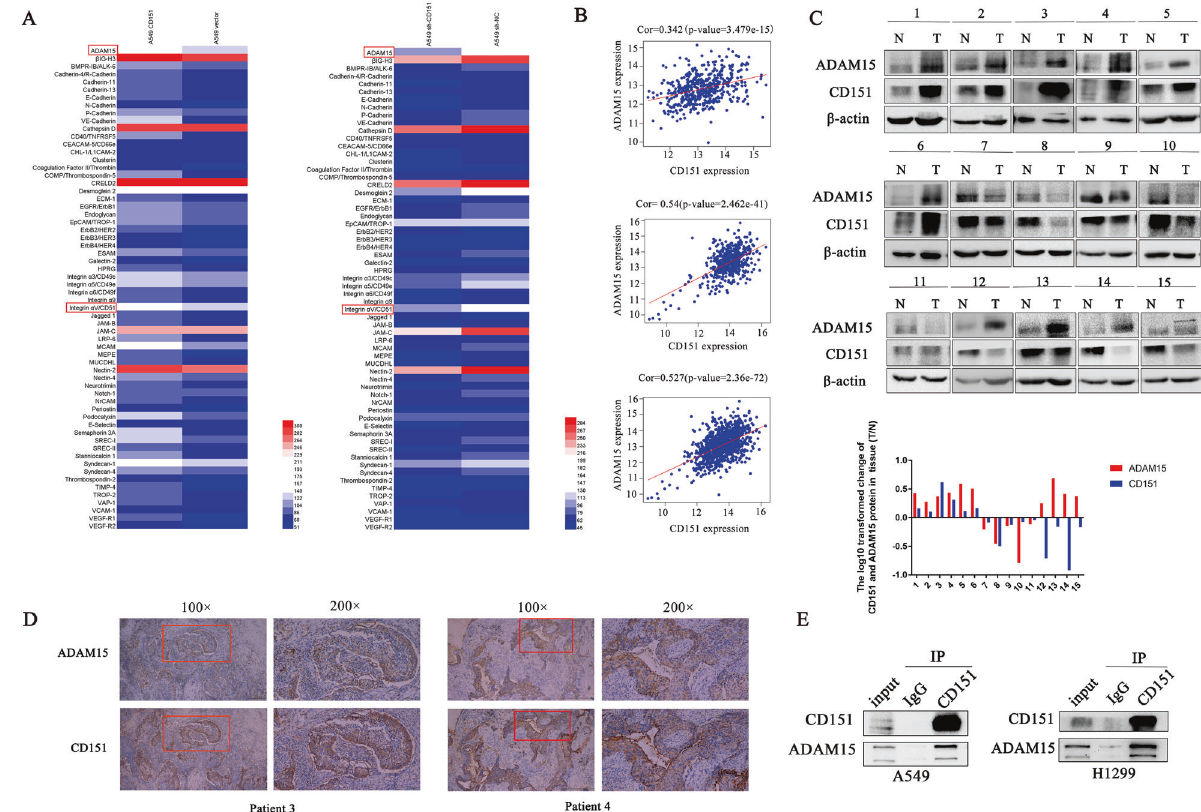
Fig. 6 ADAM15 and CD151 co-expression in NSCLC. A Hierarchical cluster analysis of microarray data (heat map) was performed to show differentially expressed proteins of A549 cells in different groups. Red and blue indicate high and low protein expression levels, respectively. B Data obtained from TCGA database (https://portal.gdc.cancer.gov/) were analysed to detect the correlation between ADAM15 and CD151 mRNA levels in lung adenocarcinoma, lung squamous cell carcinoma and total lung cancer cell lines. C Western blot analysis of the ADAM15 and CD151 protein levels in 15 randomly selected NSCLC tissues and paired noncancerous lung tissues. D NSCLC samples were co- immunostained with an anti-CD151 antibody and anti-ADAM15 antibody. E Co-immunoprecipitation of ADAM15 and CD151 is shown. Protein was immunoprecipitated and detected from parental A549 and H1299 cells using a speci fi c monoclonal antibody. Bars represent the mean ± SEM from three independent experiments. * P < 0.05; ** P < 0.01; *** P <